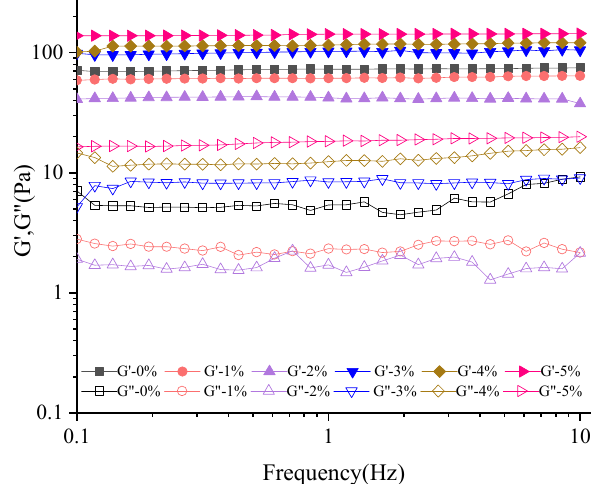
Figure 2. Storage modulus (G ′ ) and loss modulus (G ″ ) versus frequency for soybean isolate protein content in composite gels at 0–5%.